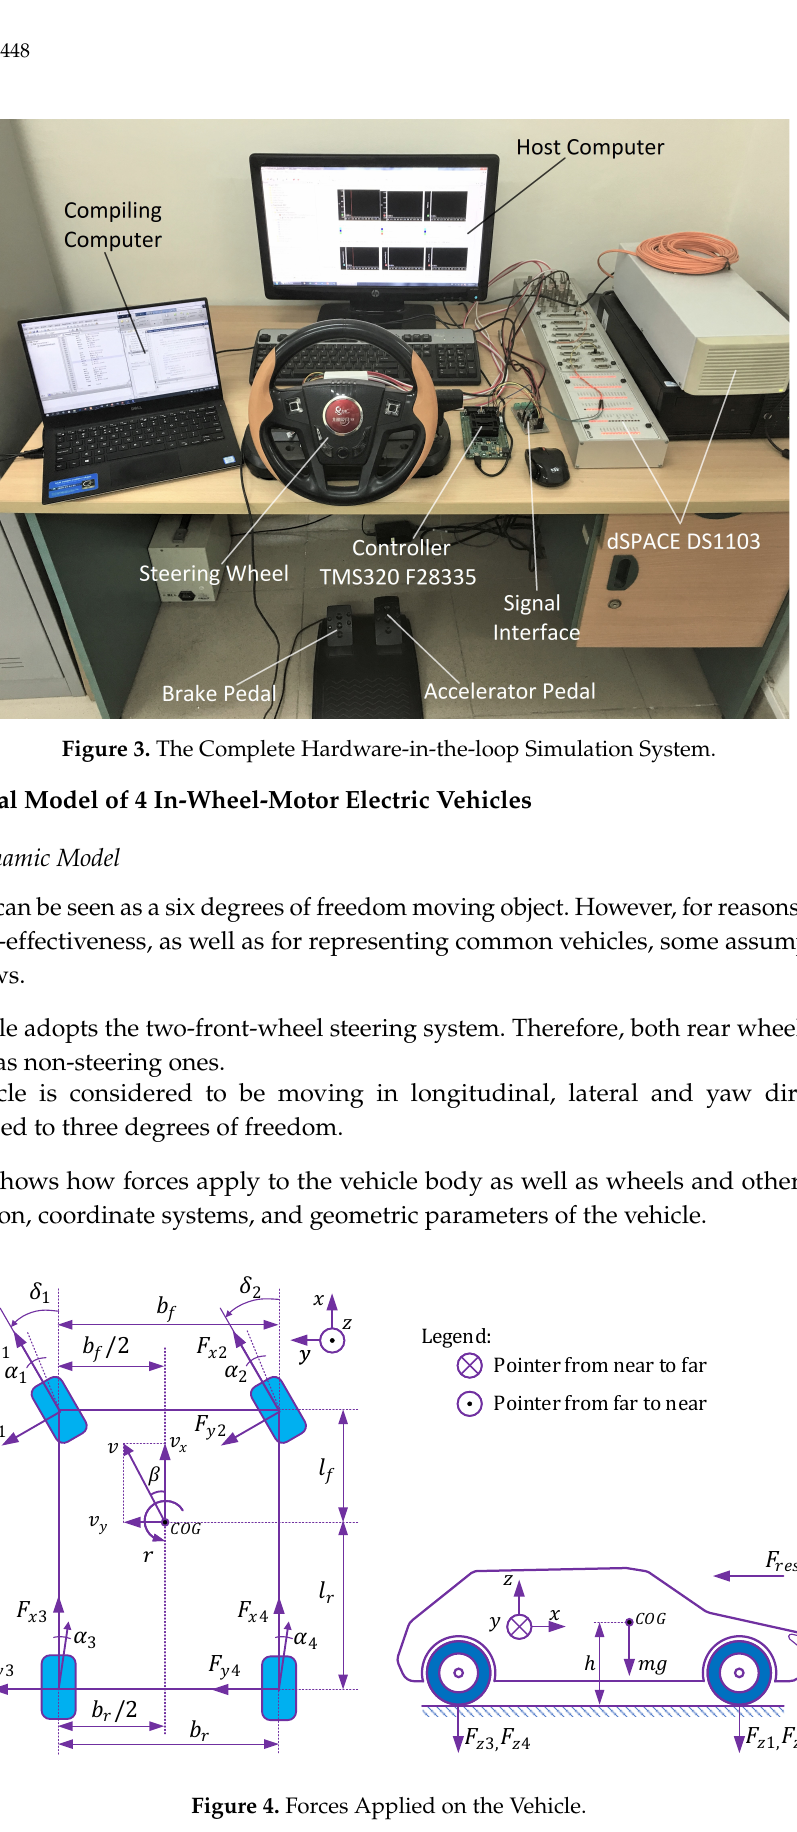
Figure 4. Forces Applied on the